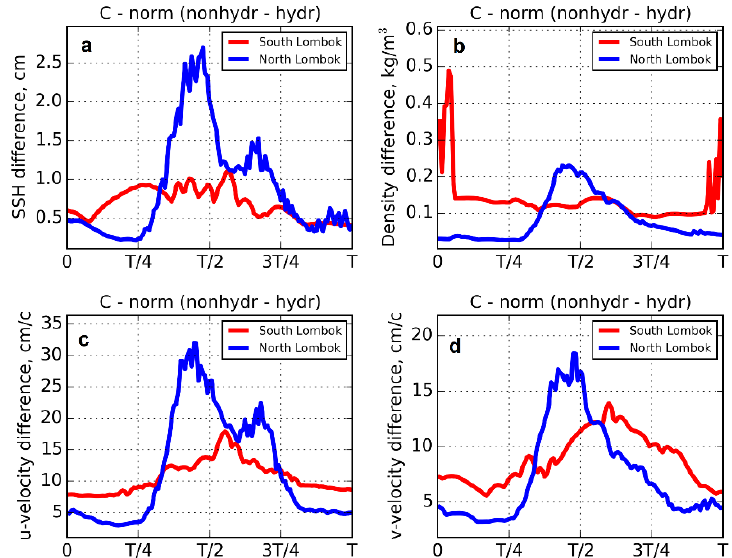
Figure 6. The difference in the solutions in Nh and Hs problems for the four components of the solution (( a ) sea level, ( b ) density and ( c , d ) two components of horizontal velocity) in the